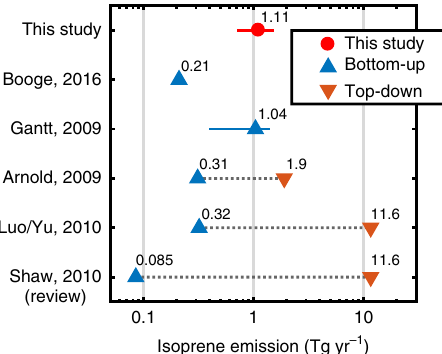
Fig. 4 Comparison of current global isoprene emission estimates and the results of our study (0.70 – 1.52 Tg yr − 1 ). The bottom-up estimates are based on direct biological emissions only, whereas top-down refers to expected total isoprene emissions from global model